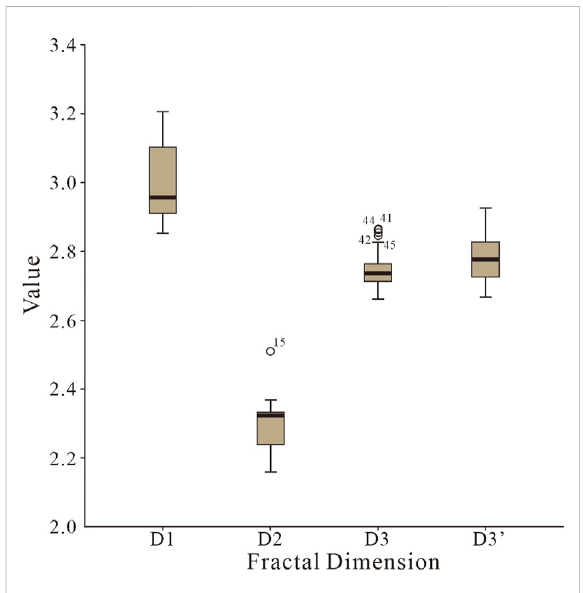
FIGURE 13 Box plot of fractal dimension multi-scale calculation